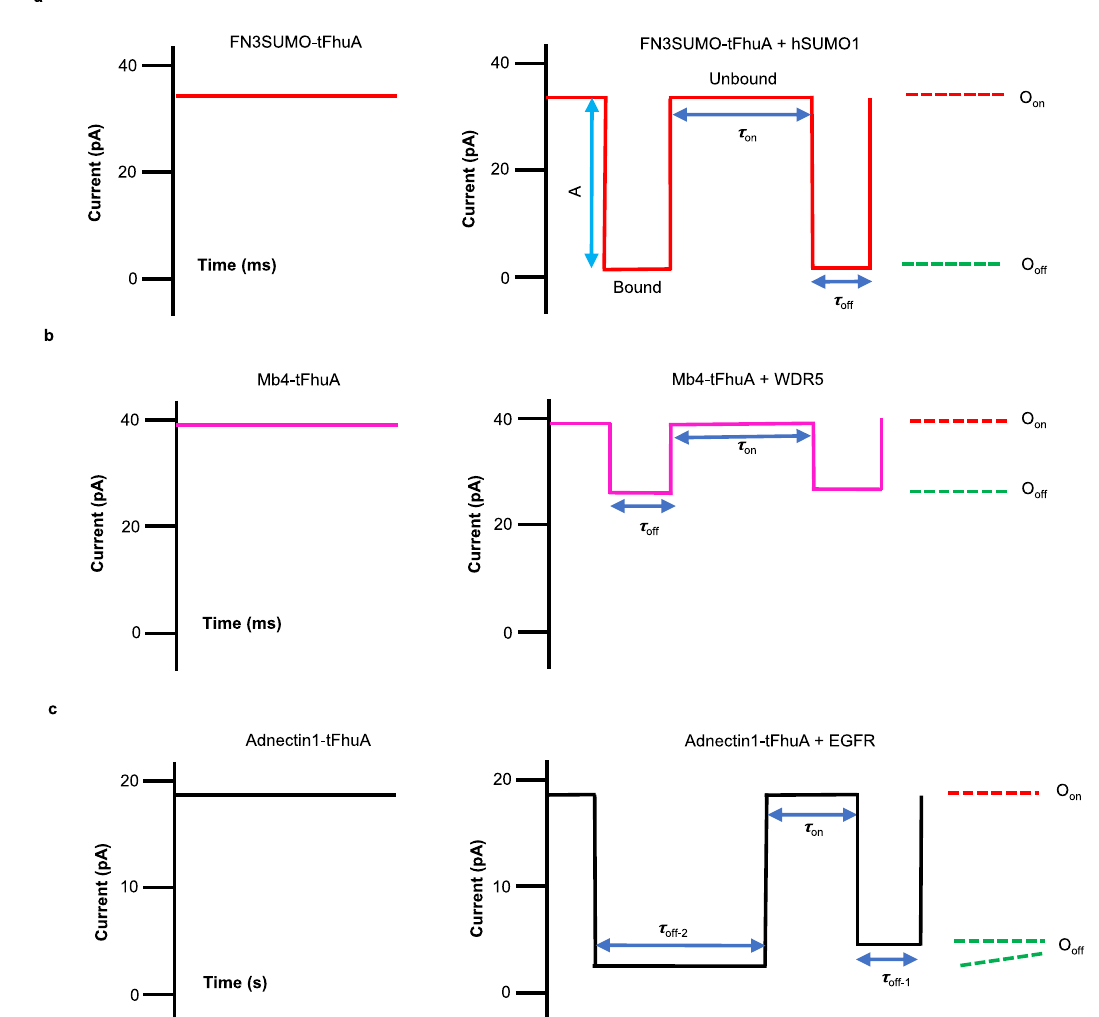
Fig. 6 | Schematic of the relative current blockades acquired with FN3SUMO- tFhuA, Mb4-tFhuA, and Adnectin1-tFhuA. O on and O off are the protein analyte- released and protein analyte-captured substates, respectively. τ on and τ off are the durations of the protein analyte-released and protein analyte-captured events, respectively. a Graphic representation of stochastic sensing of hSUMO1 using an FN3SUMO-tFhuA sensor, which maintains an open-state current (left panel). When hSUMO1 is added to the cis side, the analyte produces large-amplitude ( A ), medium-lived current transitions between two current substates (right panel).